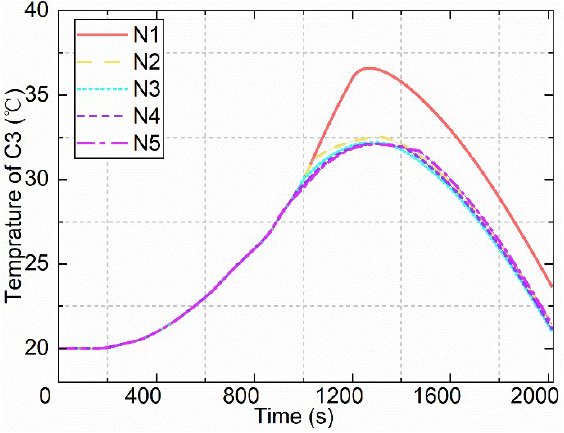
Figure 13. Temperature of different nodes in